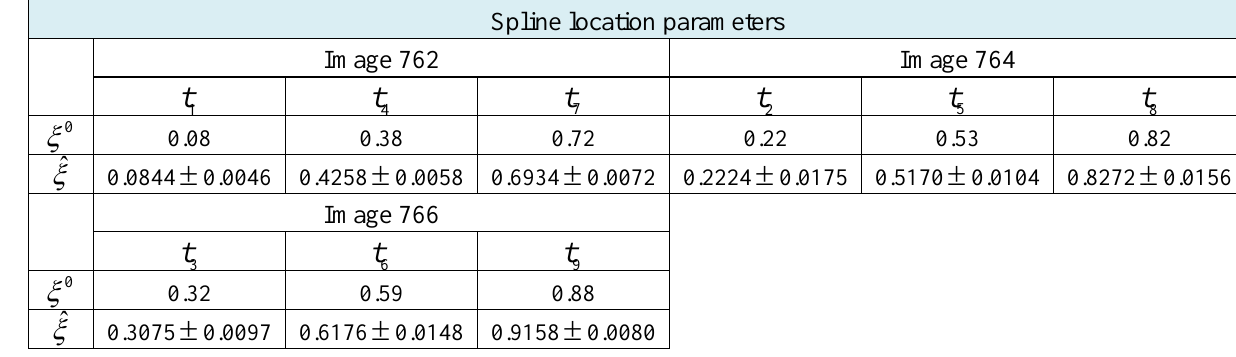
Table 9. Spline parameter and spline location parameter